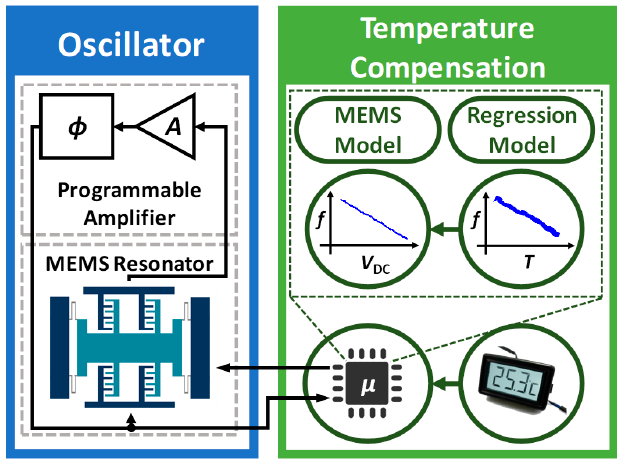
Figure 1. Overview of the temperature-compensated oscillator.